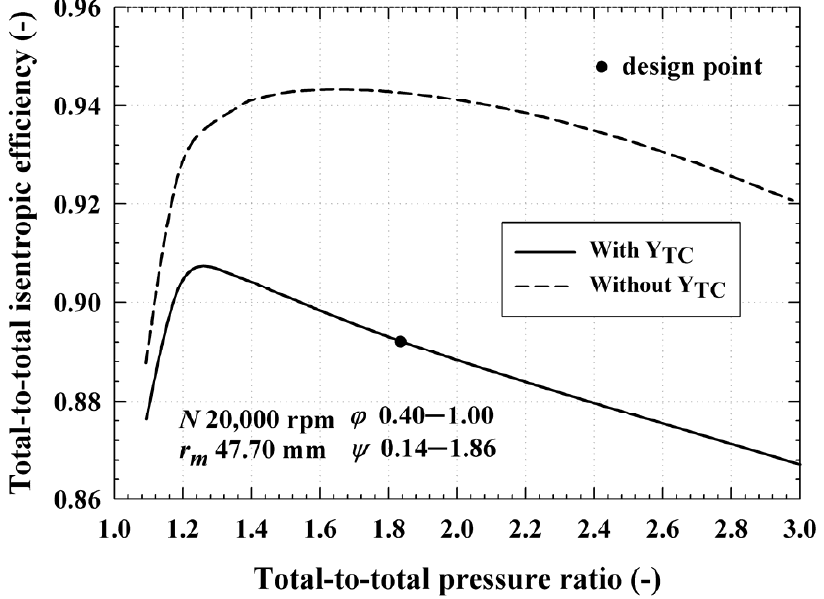
Figure 10. Total-to-total isentropic efficiency of the turbine ( 𝜂